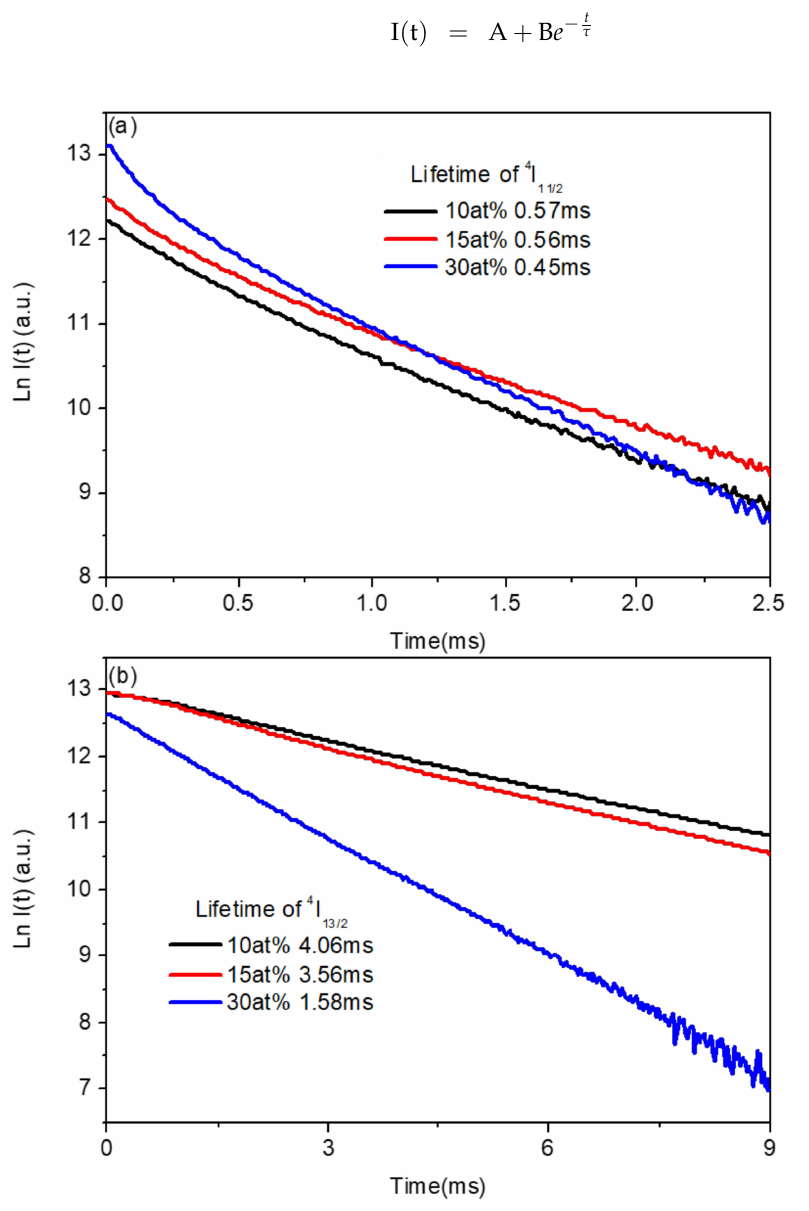
Figure 11. Fluorescence decay time of ( a ) 4 I 11/2 and ( b ) 4 I 13/2 with different concentration of Er 3+ ions at room